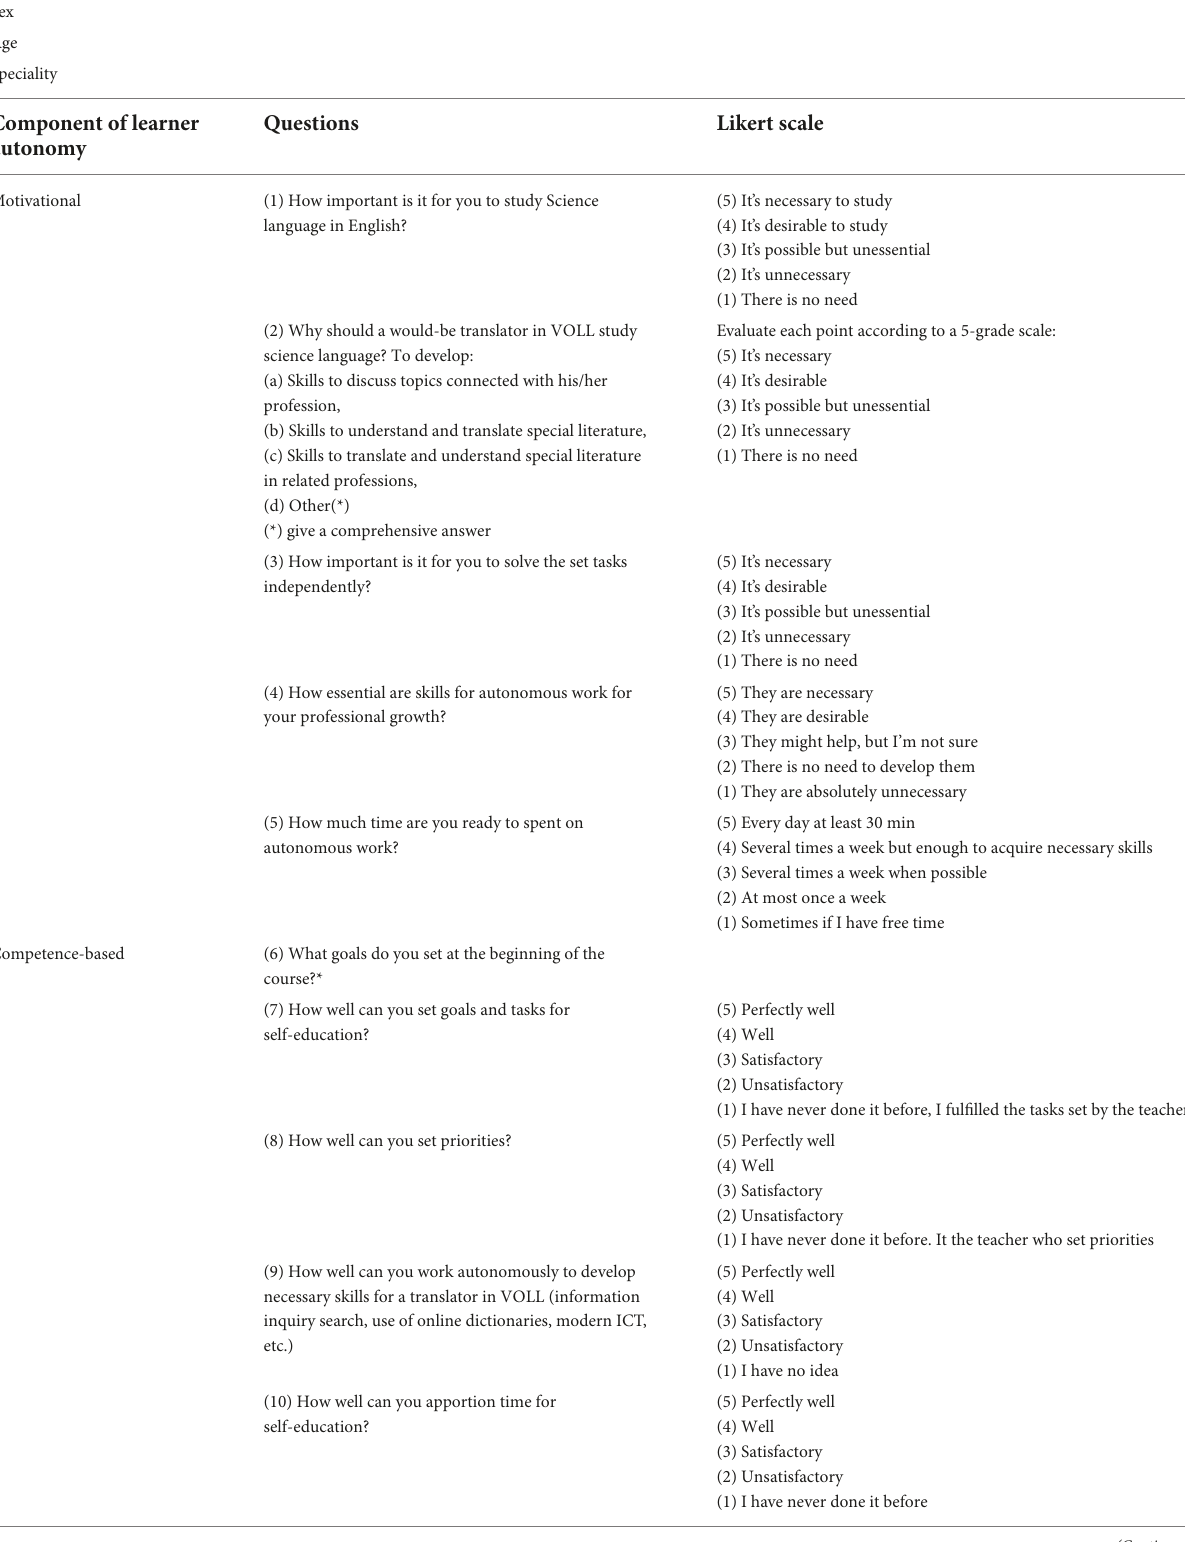
TABLE 1 Questionnaire at the self-check